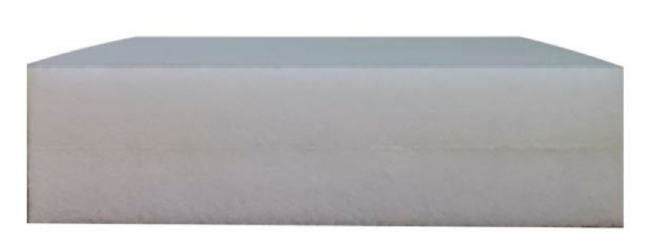
Figure 2. Physical appearance of evaluated PLON blocks.